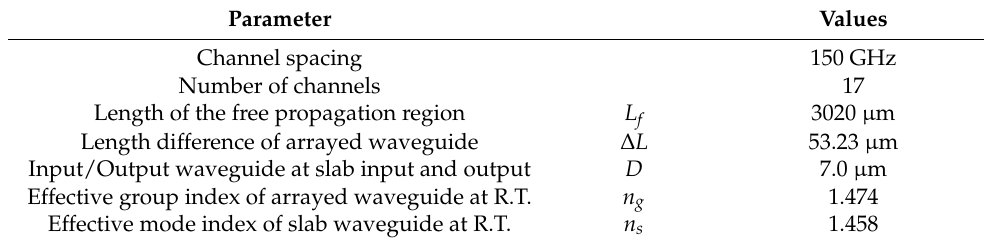
Table 1. Circuit parameters for 17-channel (150 GHz-spacing) AAWG [15]. Parameter Values Channel spacing 150 GHz Number of channels 17 Length of the free propagation region L f 3020 µ m Length difference of arrayed waveguide ∆ L 53.23 µ m Input/Output waveguide at slab input and output D 7.0 µ m Effective group index of arrayed waveguide at R.T. n g 1.474 Effective mode index of slab waveguide at R.T. n